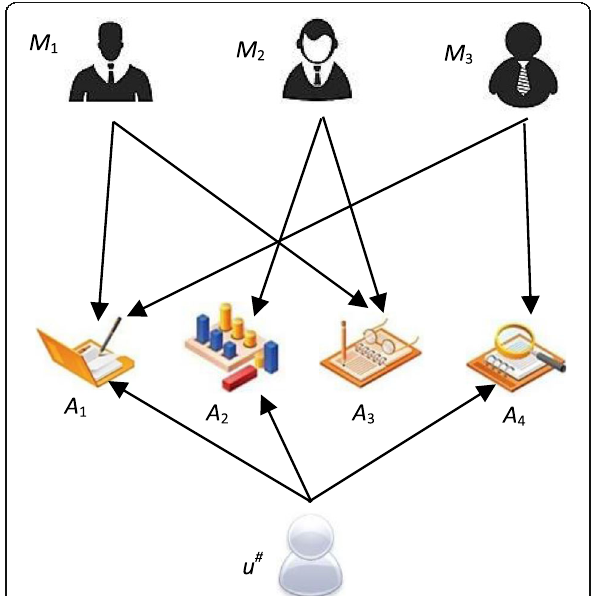
Fig. 1 Privacy-aware friend-finding based on thumbs-up data: an